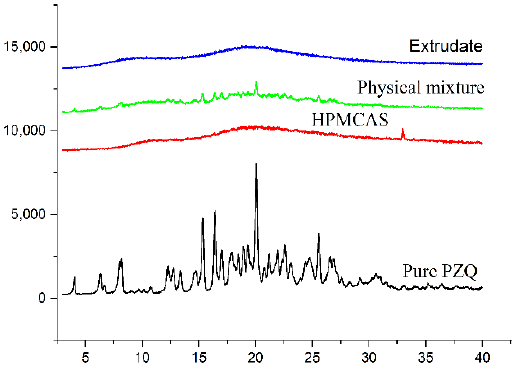
Figure 3. XRD thermograms of pure PZQ, a physical mixture, extrudate and HPMCAS.